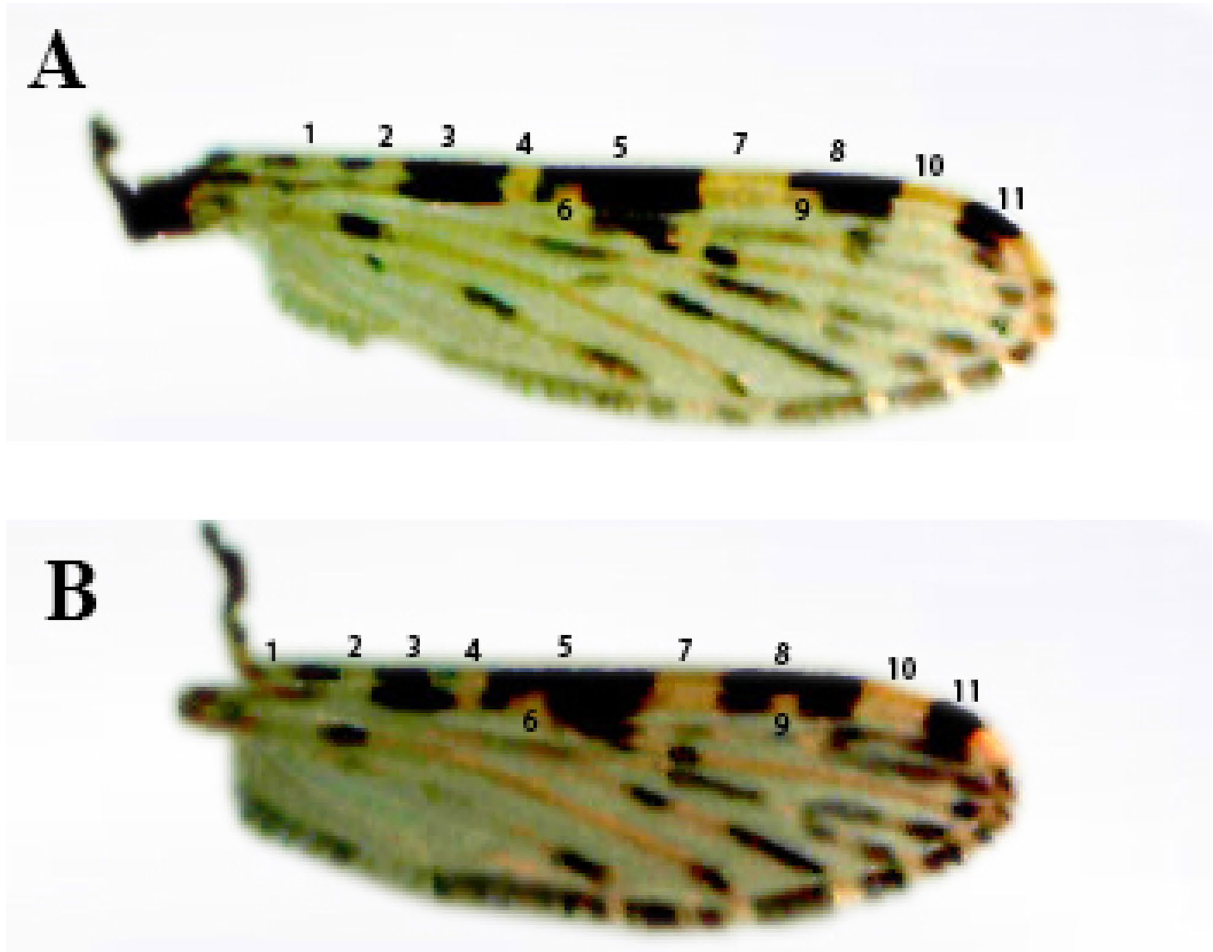
Figure 2. ( A ) Morphological appearance and nomenclature of female Anopheles gambiae s. l., wing type A: wing with interrupted pale spot (Character 9) fused with proceeding pale spot of the sub-coastal pale spot. ( B ) Morphological appearance and nomenclature of female Anopheles gambiae s. l., wing type B: wing with a pale interruption found within the pre-apical dark spot (character 8). Wing nomenclature: (1) Humoral pale spot. (2) Pre-sector pale spot, (3) Pre-sector dark spot, (4) Sector pale spot, (5) Median dark spot, (6) Accessory sector pale spot, (7) Sub-coastal pale spot, (8) Pre-apical dark spot, (9) Interruption of 3rd main dark area, (10) Sub- apical dark spot, (11) Apical pale spot.